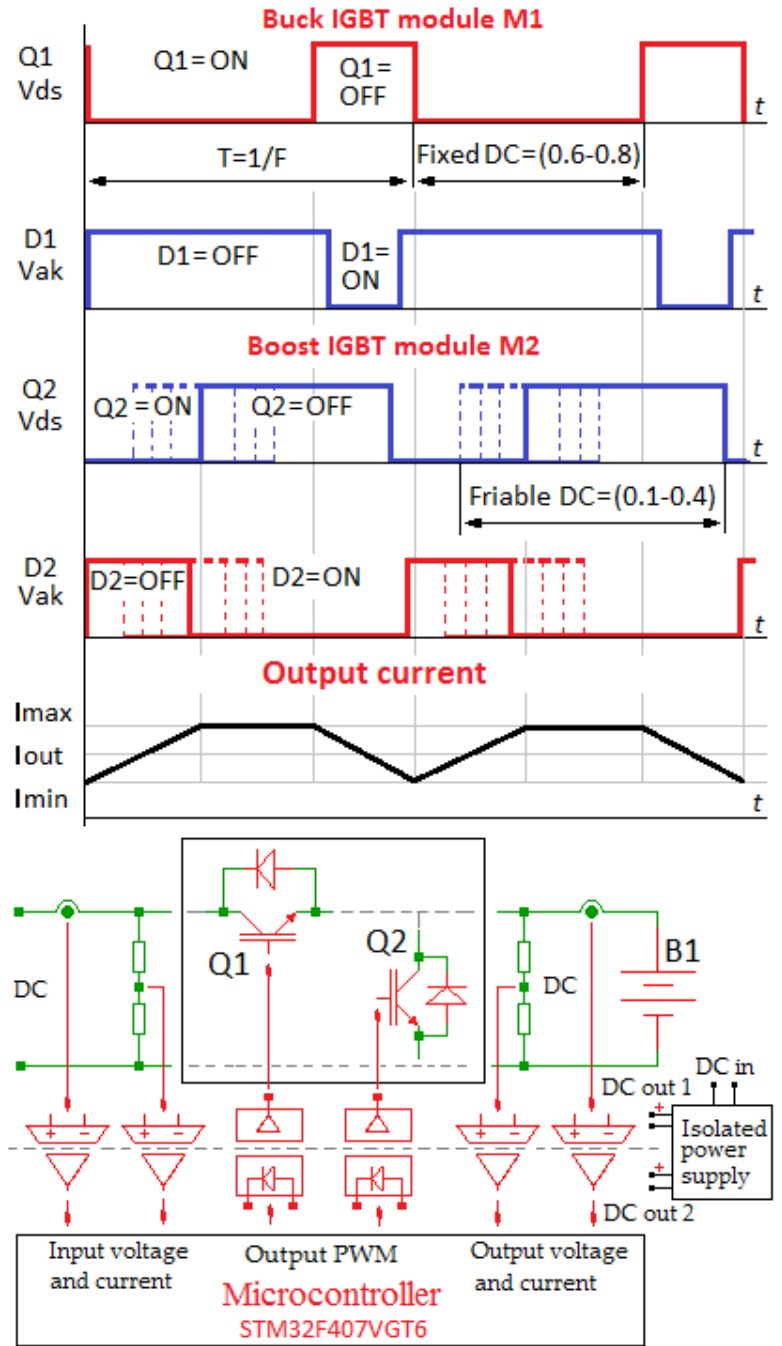
Figure 5. Buck-Boost mode of operation and block diagram of the control system.